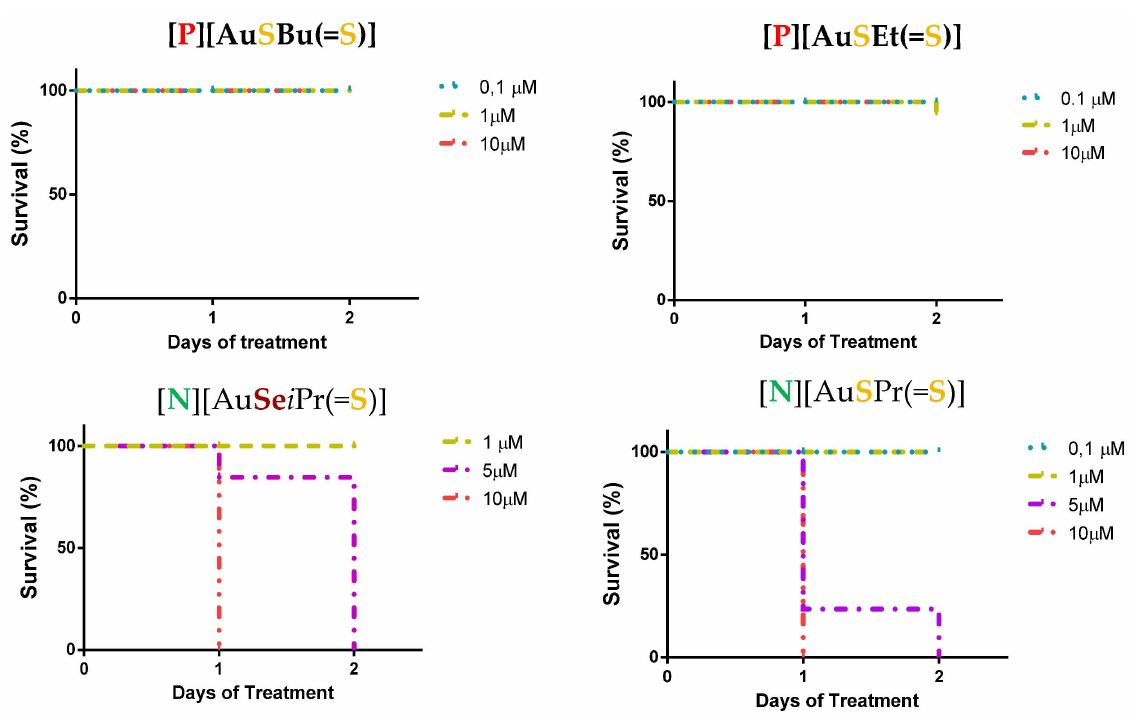
Figure 3. Zebrafish lethality curves of the acute toxicity assay at 48 h for selected Au(III) bis(dithiolene/diselenolene) complexes [ P ][AuSBu(=S)], [ P ][AuSEt(=S)], [ N ][AuSe i Pr(=S)] and [ N ][AuSPr(=S)]. In total, 72 hpf zebrafish embryos ( n = 30) were exposed to increased concen- trations of the represented complexes and mortality was evaluated after 48 h of treatment with the